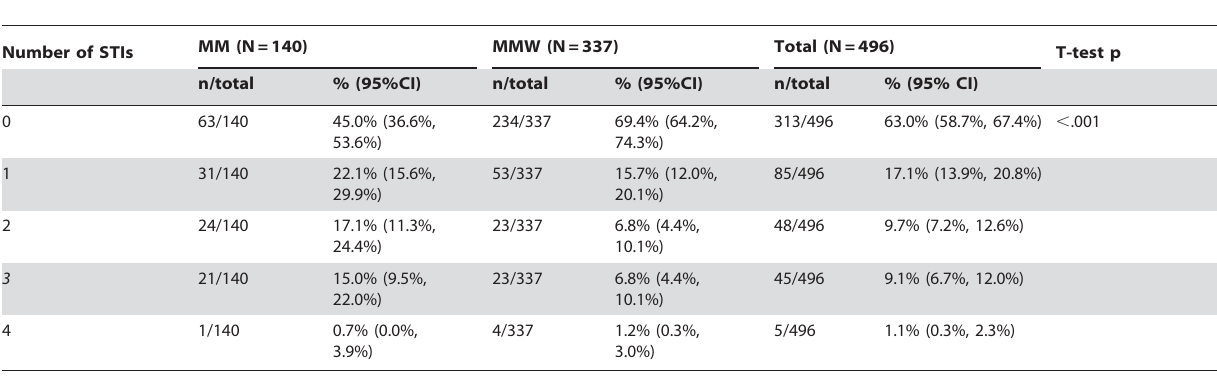
Table 2. Number of STIs according to type of partner.